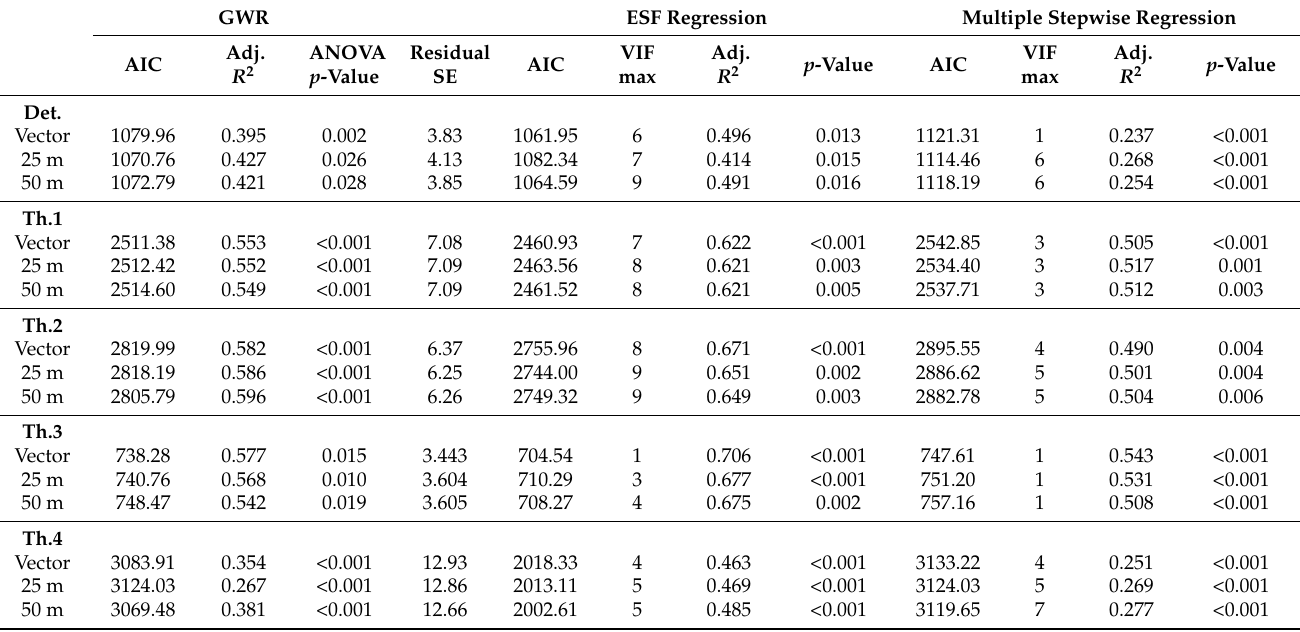
Table 2. Geographically weighted regression (GWR), eigenvector spatial filtering (ESF) regression, and multiple stepwise regression